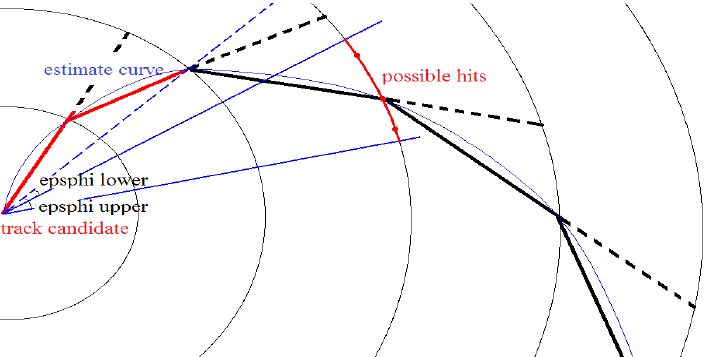
Figure 5. Track scheme in transverse